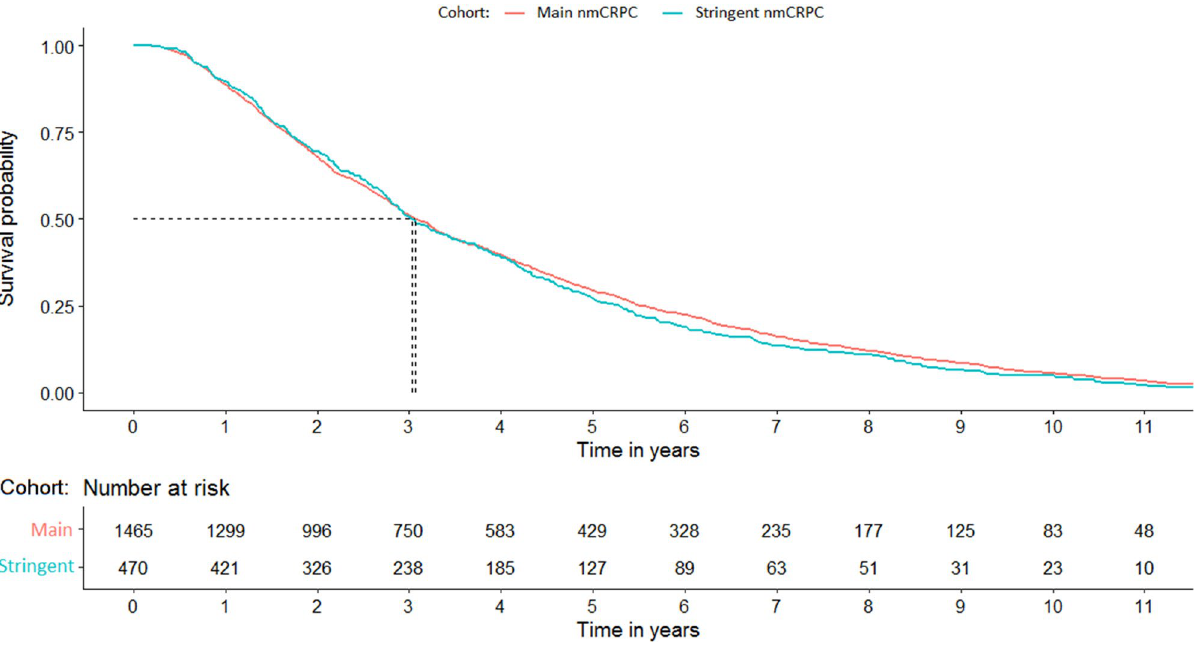
Figure 3. Time from initial PC diagnosis to meeting inclusion criteria for the main and stringent nmCRPC cohorts. nmCRPC: non-metastatic castration-resistant prostate cancer; PC: prostate cancer.